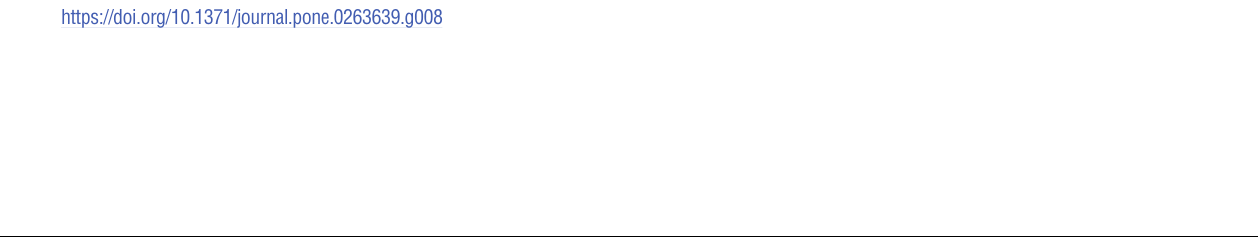
PLOS ONE | https://doi.org/10.1371/journal.pone.0263639 February 13,